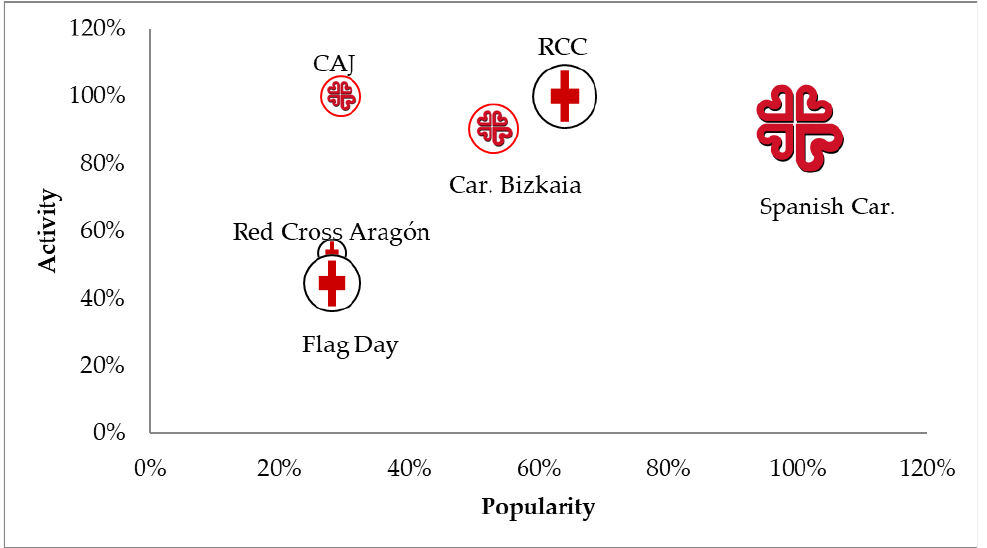
Figure 5. Positioning map according to activity and popularity dimensions.